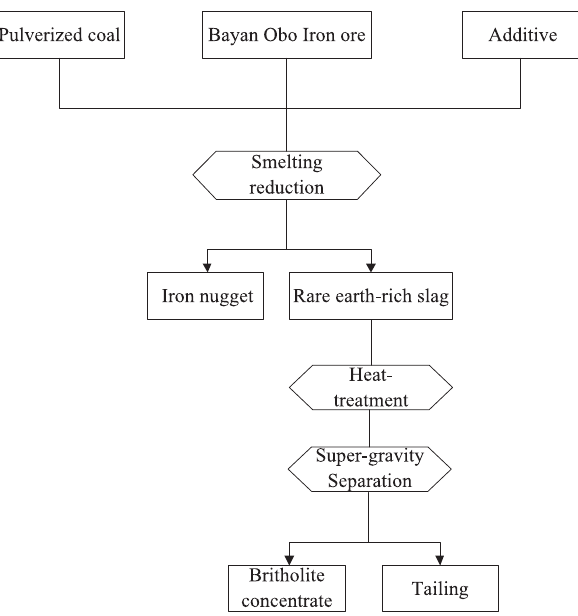
Fig. 2: Technological sheet to effectively utilize Bayan Obo complex iron ore